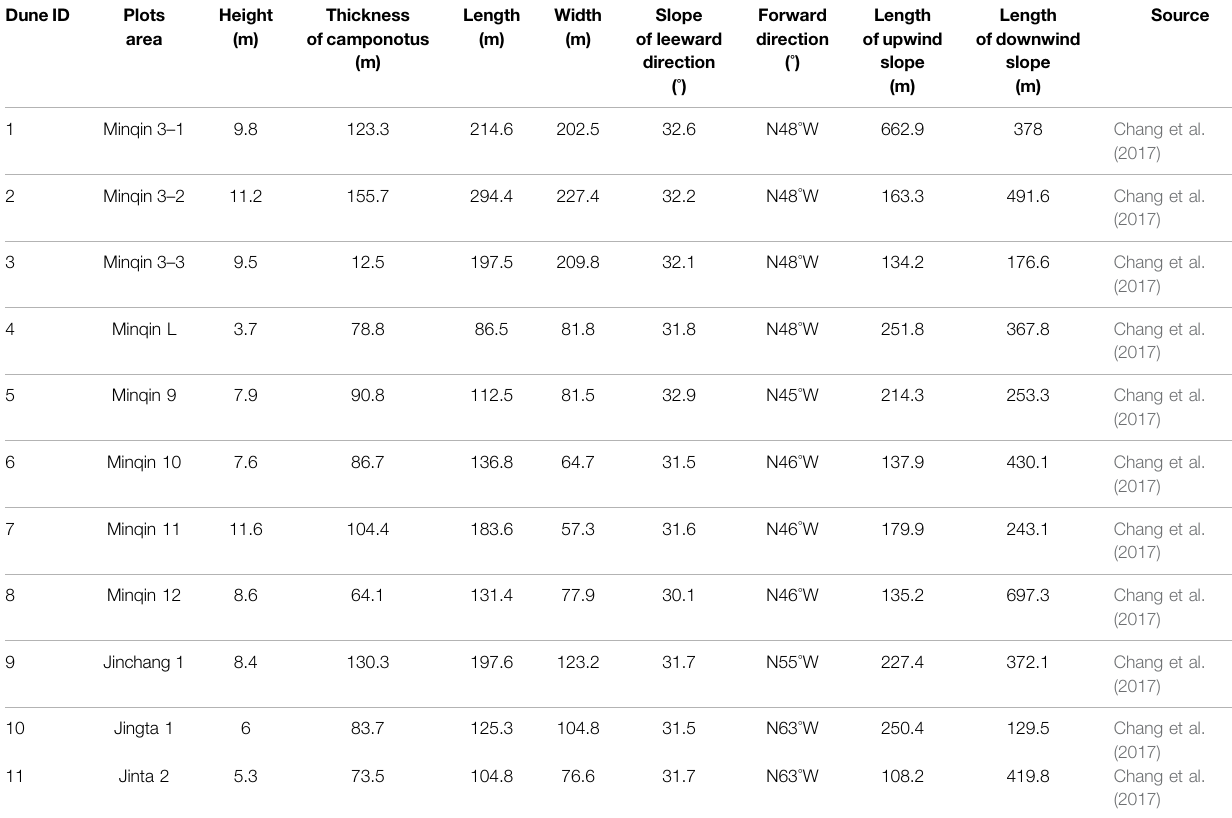
TABLE 2 | Morphological characteristics of barchans dunes in the Hexi Corridor. DuneID Plots